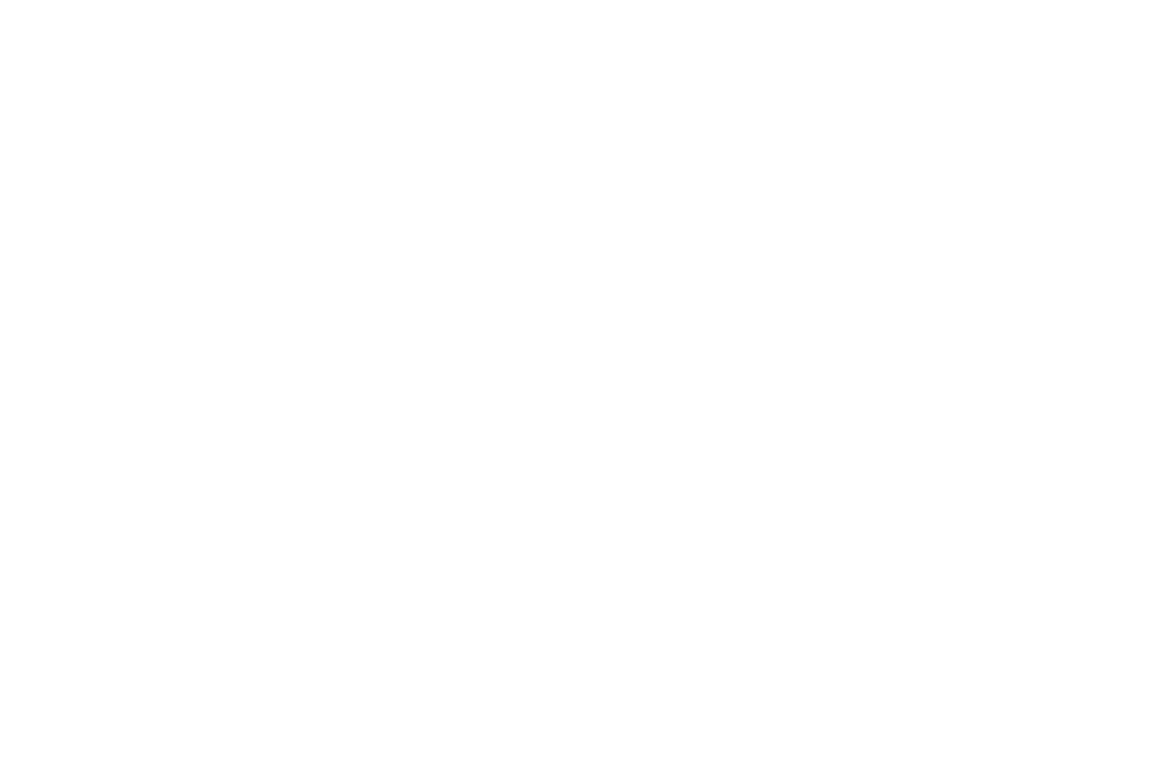
alignment of conserved putative regulatory region (PRR) approximately − 2200 to − 2700bp of human UCP1. For genome coordinates and full alignment, see